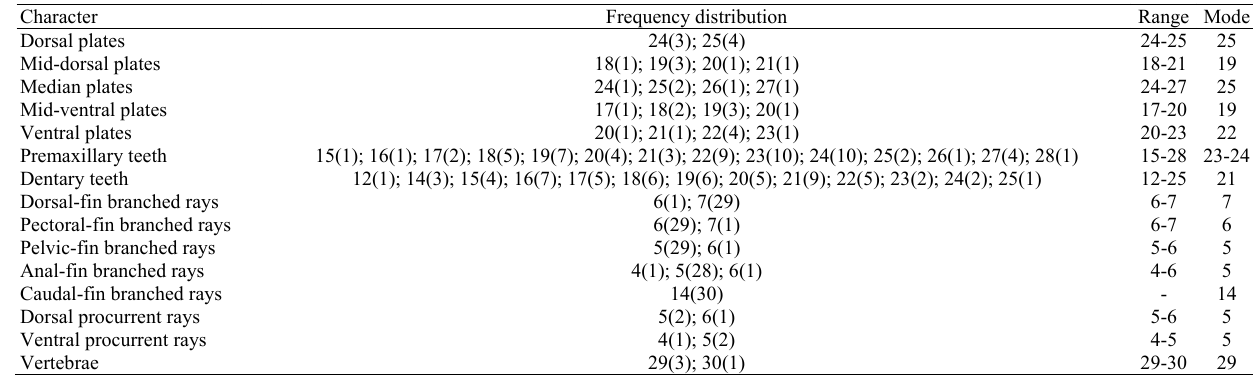
Table 2. Frequency distribution of meristic data for Microlepidogaster dimorpha . Rays and teeth counts were made for holotype (DZSJRP 10543) and for 30 paratypes (DZSJRP 5564, 8750, 12332; MCP 45866; MNRJ 37848; MZUSP 107585). Plates (counted in both sides whenever possible), procurrent rays, and vertebrae counts were made for 4 c&s paratypes (DZSJRP 8750,